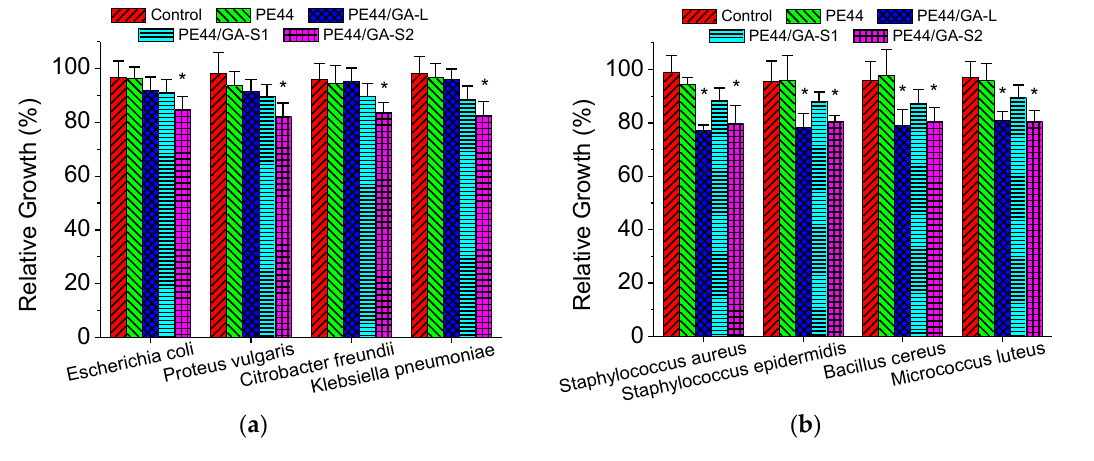
Figure 9. Bacterial growth of ( a ) Gram-negative and ( b ) Gram-positive bacteria after 24 h for unloaded and peptide-loaded PE44 fibers. Results are expressed with respect to the bacterial growth in absence of any material (control), which was considered as the maximum growth.